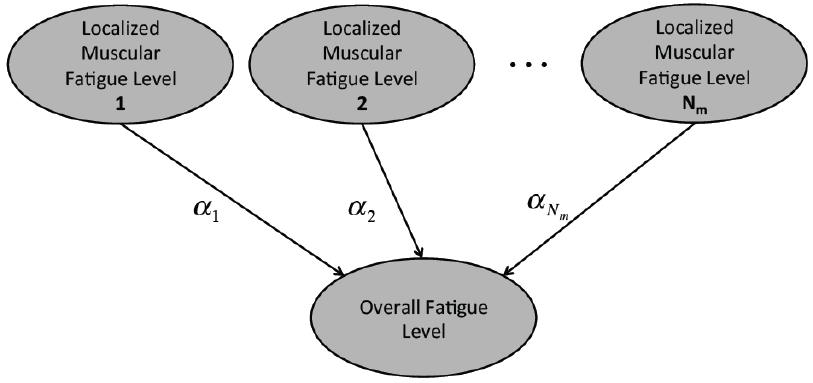
Figure 5. Fusion of localized muscular fatigue levels. Different localized muscular fatigue levels (corresponding with different muscles) are fused together to represent the overall fatigue status of a human movement.